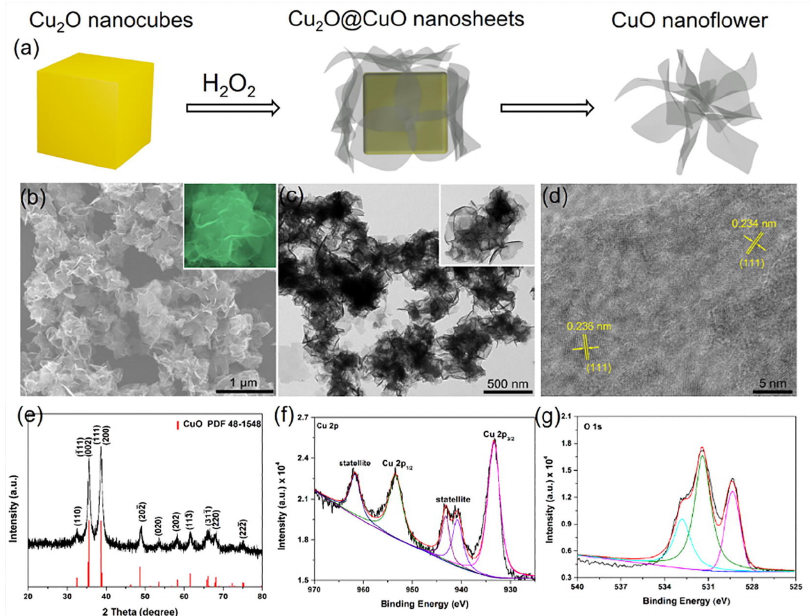
Figure 3. ( a ) Schematic of the template-based synthesis of CuO nanoflowers; ( b ) low-magnification field emission scanning electron microscopy (FE-SEM), ( c ) TEM, and ( d ) HR-TEM images; ( e ) XRD pattern; and ( f ) Cu 2p and ( g ) O 1s XPS spectra of CuO nanoflowers. Insets in ( b , c ) are the corresponding individual nanoflowers. Reprinted with permission from Ref. [92]. Copyright 2018, Elsevier.